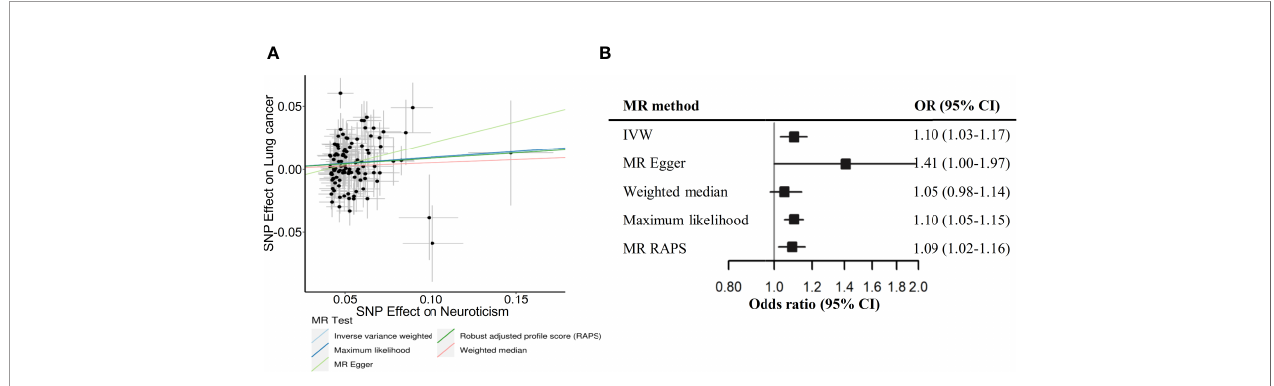
FIGURE 1 | Scatterplot (A) and forest plot (B) depicting Mendelian randomization (MR) results for neuroticism and risk of lung cancer. N SNPs , number of SNP instruments used in the MR analysis; OR, odds ratio; CI, con fi dence interval; IVW, Inverse variance weighted; RAPS, Robust adjusted pro fi le score - Huber loss function.